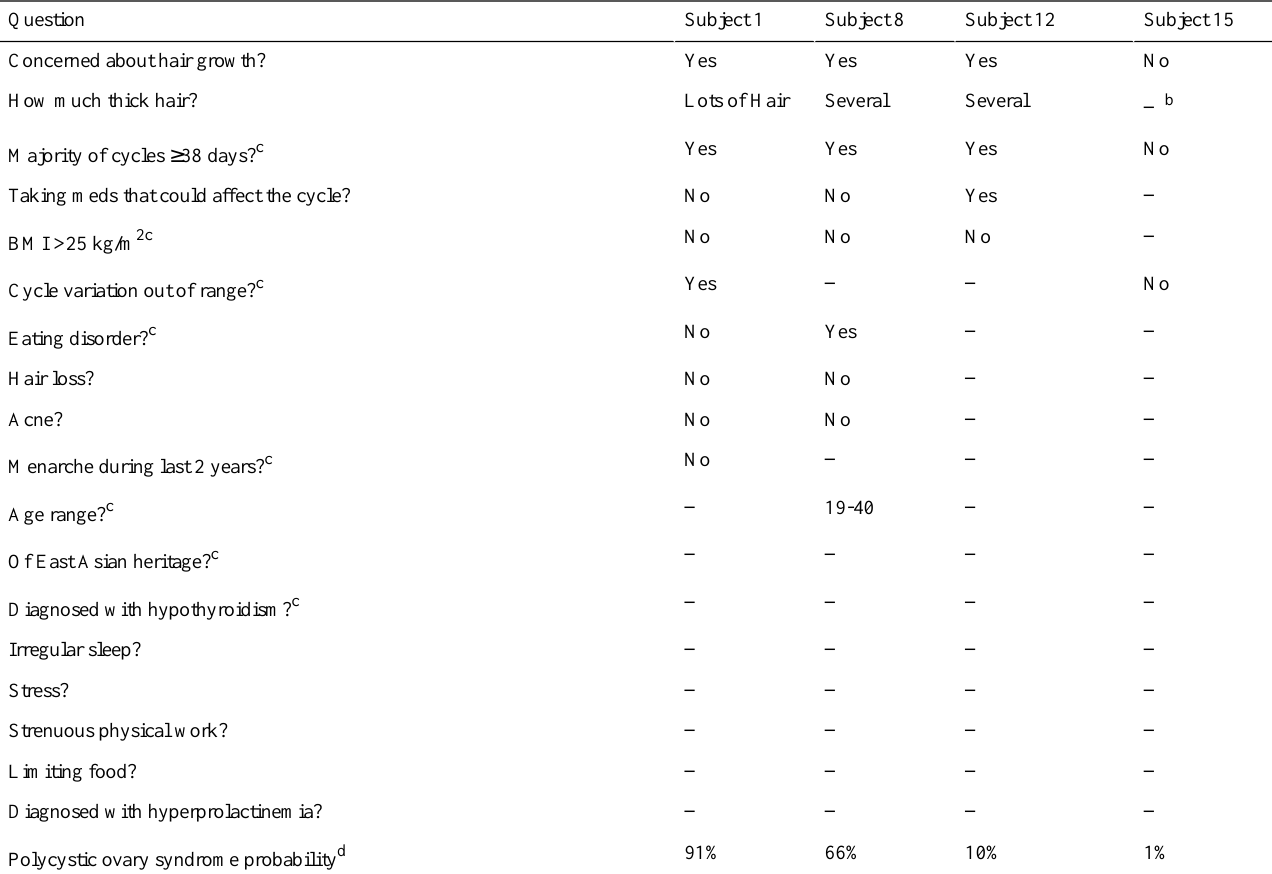
Table 6. Sample questions, answers, and probabilities using irregular cycle feature.